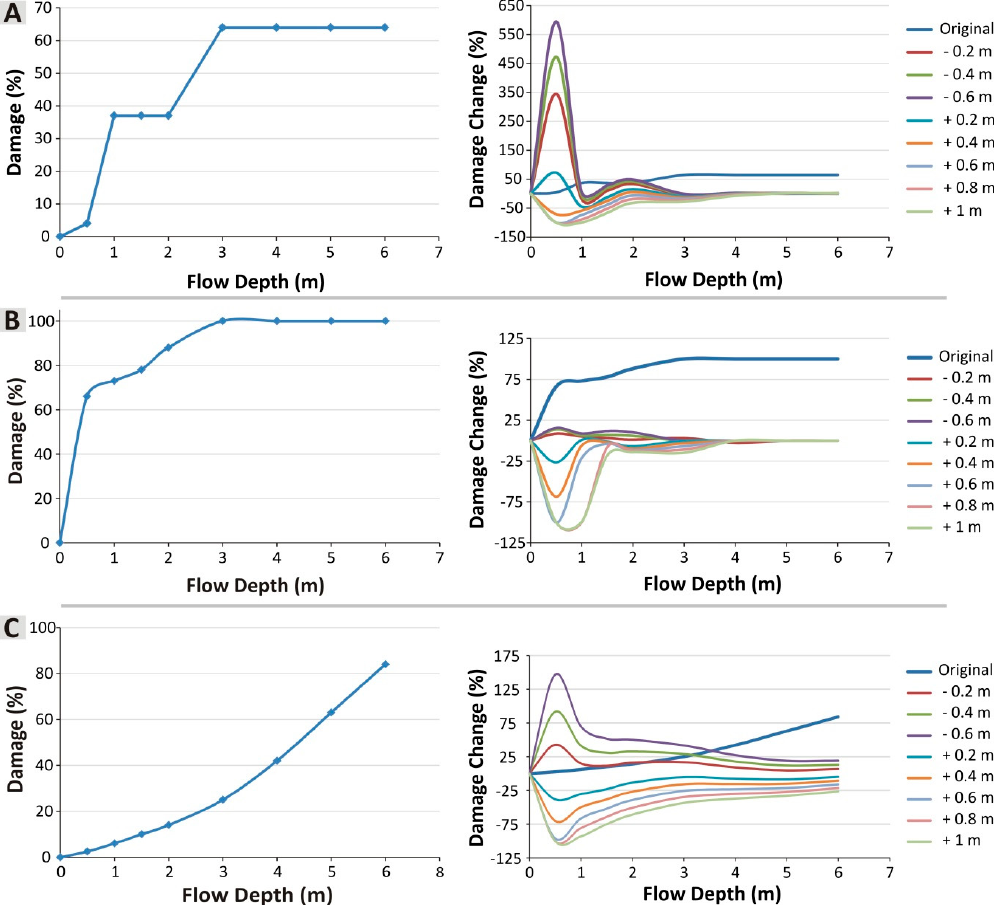
Figure 6. Examples of the effect of the magnitude–damage model graphic shape in the economic damage change evolution when considering the topographic over– or under–elevation of building main floor. The examples are related to magnitude–damage models of Switzerland ( A ), United Kingdom ( B ) and Germany ( C